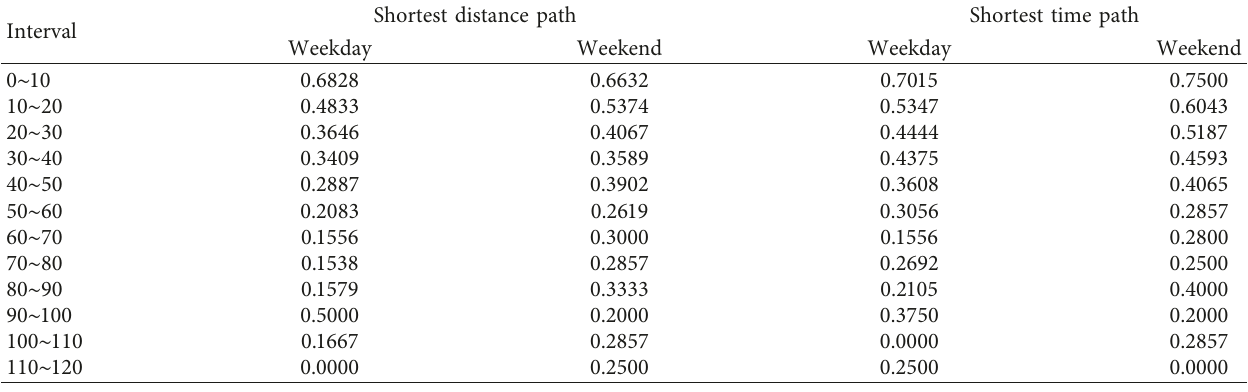
Figure 13: A global selection of different time intervals for the shortest paths. Table 14: Segment selection of different time intervals for the shortest paths.